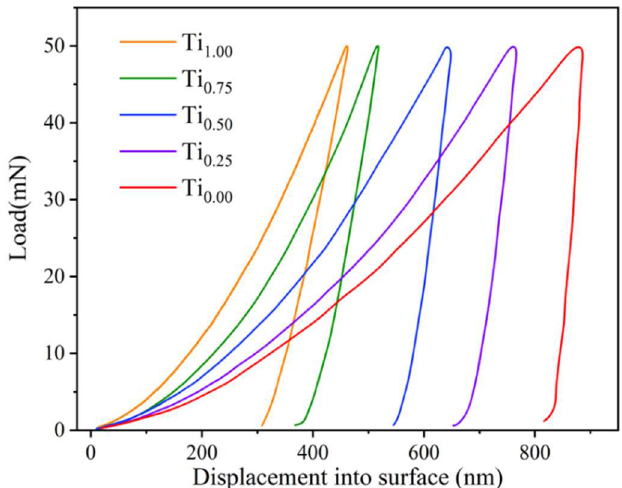
Figure 9. Load–displacement curves of the CoCrFeMnNiTi x HEA coatings.